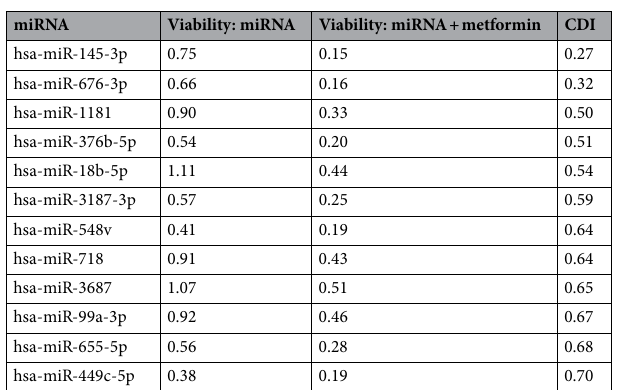
Table 1. Coefficient of drug interaction for secondary screen miRNAs. Values represent mean viability normalized to the siOTP control mean viability.